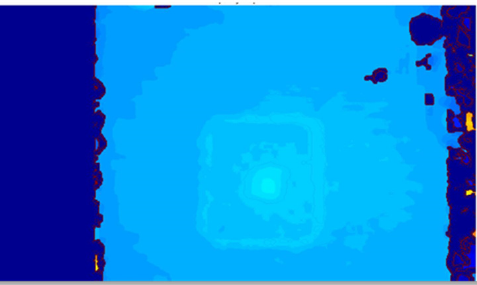
Figure 9. Disparity map obtained after stereo matching the left image with respect to the right image; the color bar represents the disparity level.